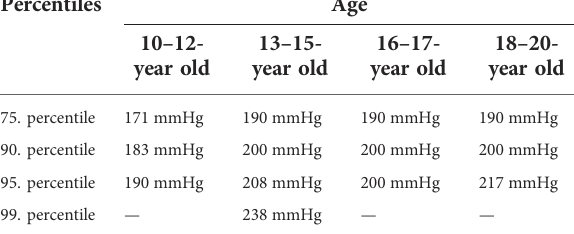
TABLE 8 Age dependent blood pressure percentiles of female younior